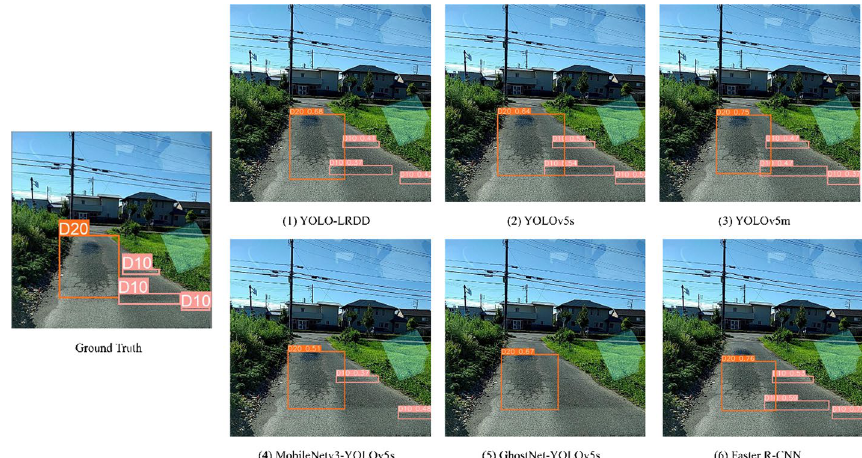
Fig. 9 Comparison of the detection in multiple small lateral cracks and alligators